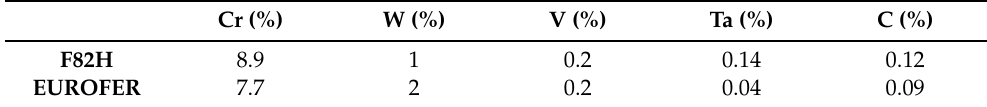
Table 2. Composition of F82H and EUROFER steels. Adapted from Ref.